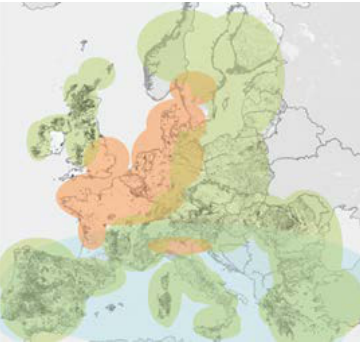
Figure 1. Environmental challenges for European agriculture (EEA, 2012)